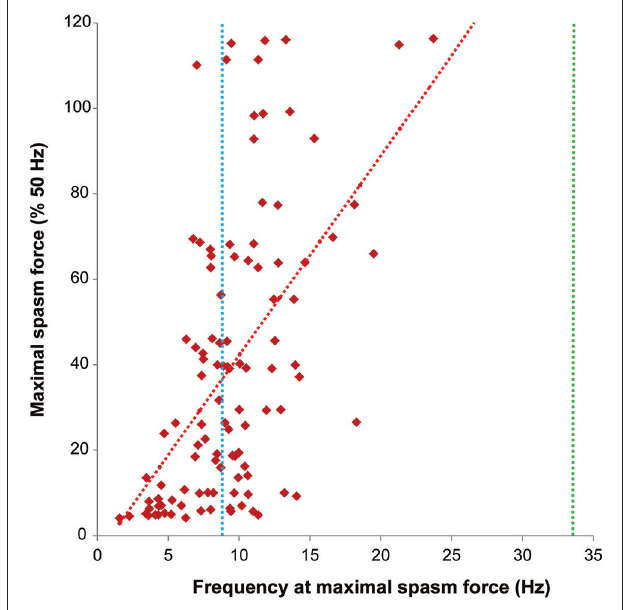
FIGURE 5 | Firing rate (Hz) at maximal spasm force vs. maximal spasm force (% 50 Hz force) . The red interrupted line shows the least squares regression line ( R 2 = 0.30). The dotted lines indicate the average firing rates of motor units during maximal voluntary contractions of the thenar muscles in subjects after spinal cord injury (SCI) (9.2 Hz, blue; Zijdewind and Thomas, 2003) and in able-bodied subjects (34.1 Hz, green; Thomas,